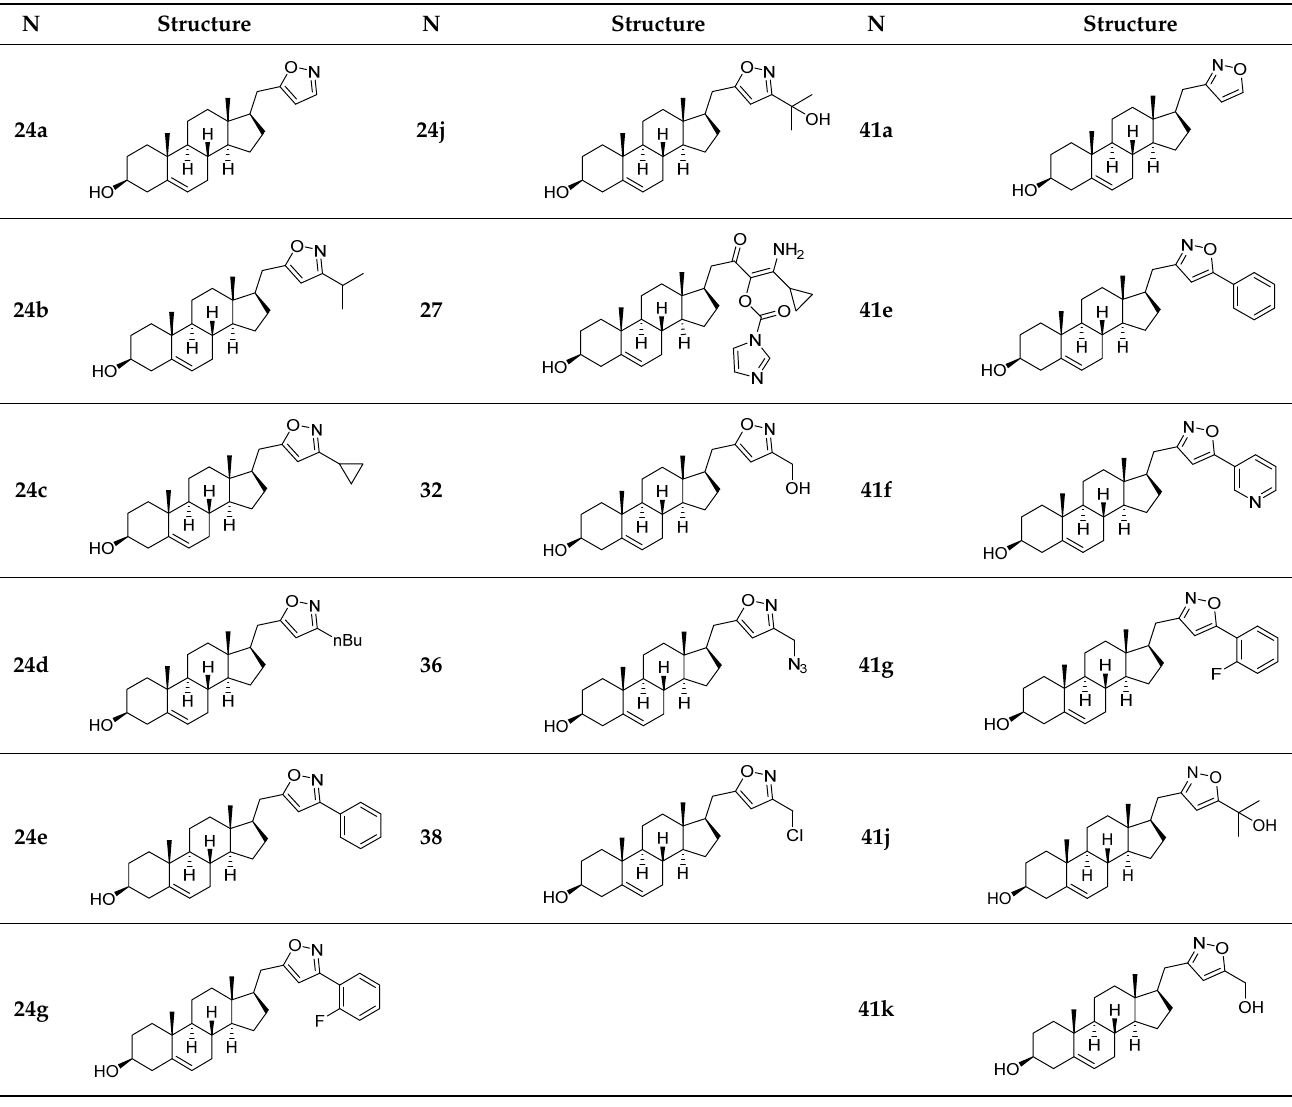
Table 1. Compounds used for biological studies. Table 1 . Compounds used for biological studies. Table 1 . Compounds used for biological studies. Table 1 . Compounds used for biological studies. Table 1 . Compounds used for biological studies. Table 1 . Compounds used for biological studies. Table 1 . Compounds used for biological studies. Table 1 . Compounds used for biological studies. Table 1 . Compounds used for biological studies. Table 1 . Compounds used for biological studies. Table 1 . Compounds used for biological studies. Table 1 . Compounds used for biological studies. Table 1 . Compounds used for biological studies. Table 1 . Compounds used for biological studies. Table 1 . Compounds used for biological studies. Table 1 . Compounds used for biological studies. Table 1 . Compounds used for biological studies. Table 1 . Compounds used for biological